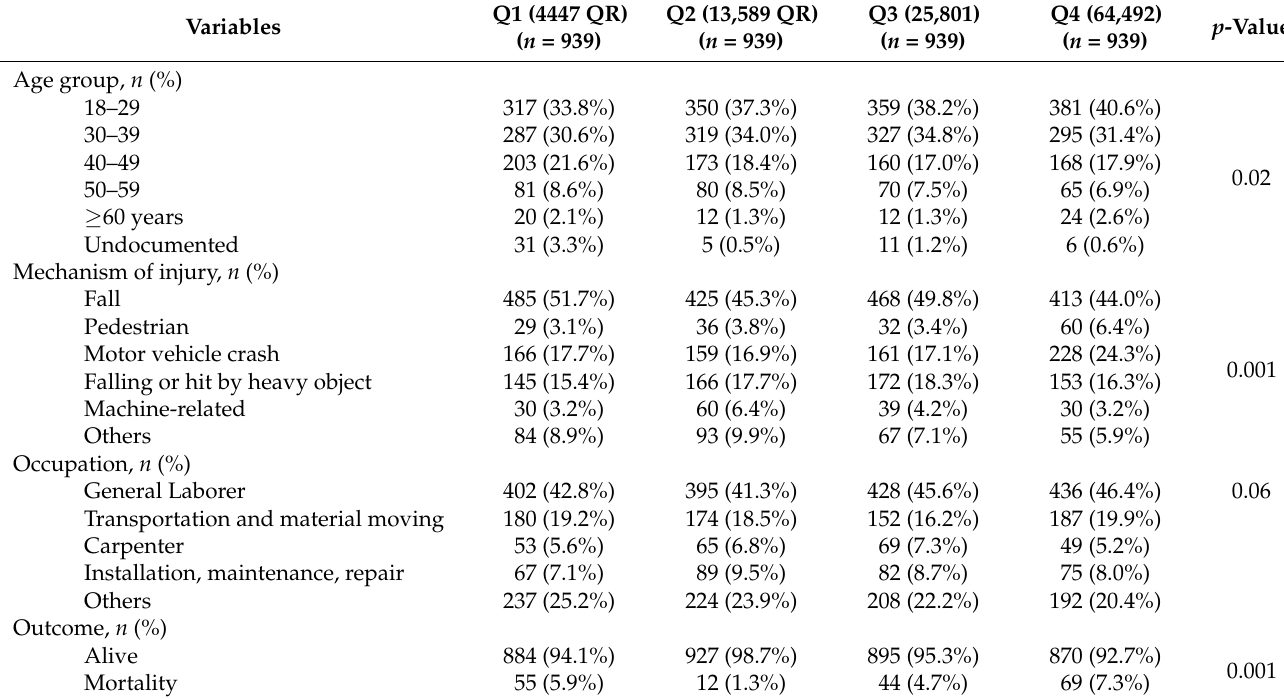
Table 3. Comparison of patient characteristics by costs associated with work-related injuries by quartile, Hamad Trauma Center, Qatar (2011–2017) ( n = 3766).